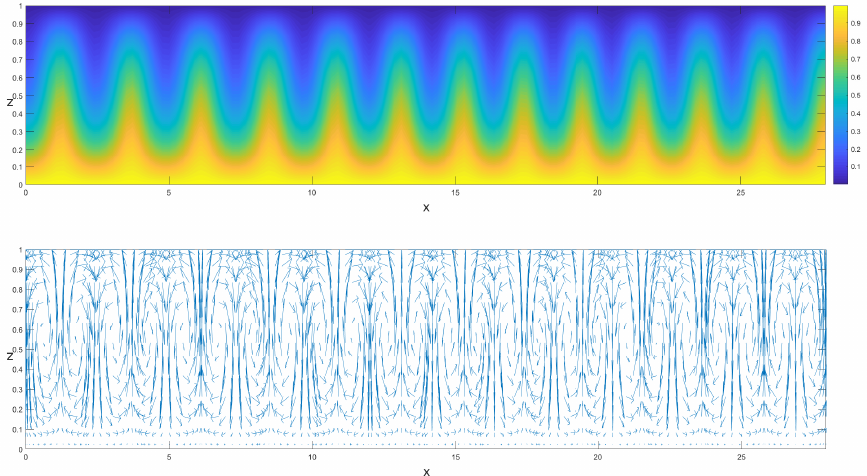
Figure 6. Isotherms and velocity field of the numerical solution obtained with alternating Schwarz; R = 1300 and Γ = 27.96.